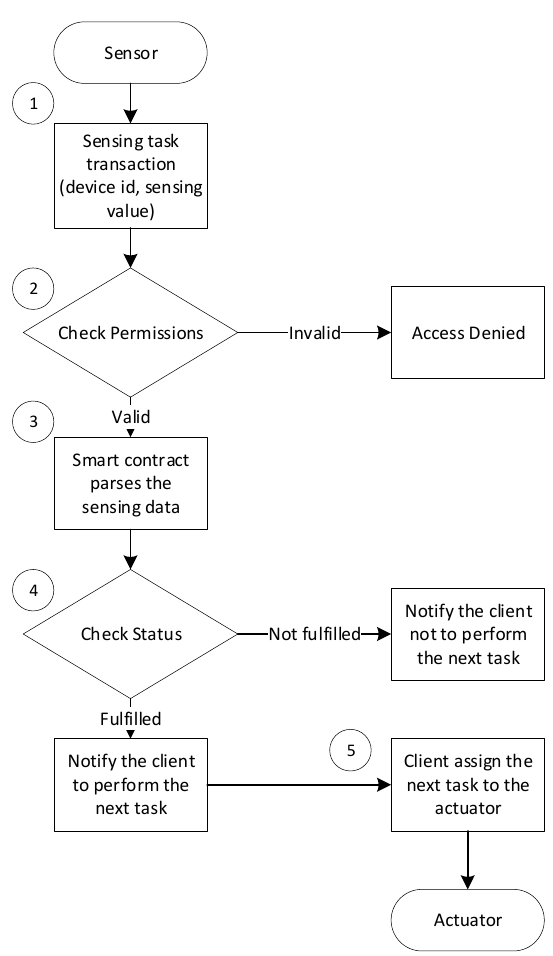
Figure 4. Flow chart of the execution and verification of a task.